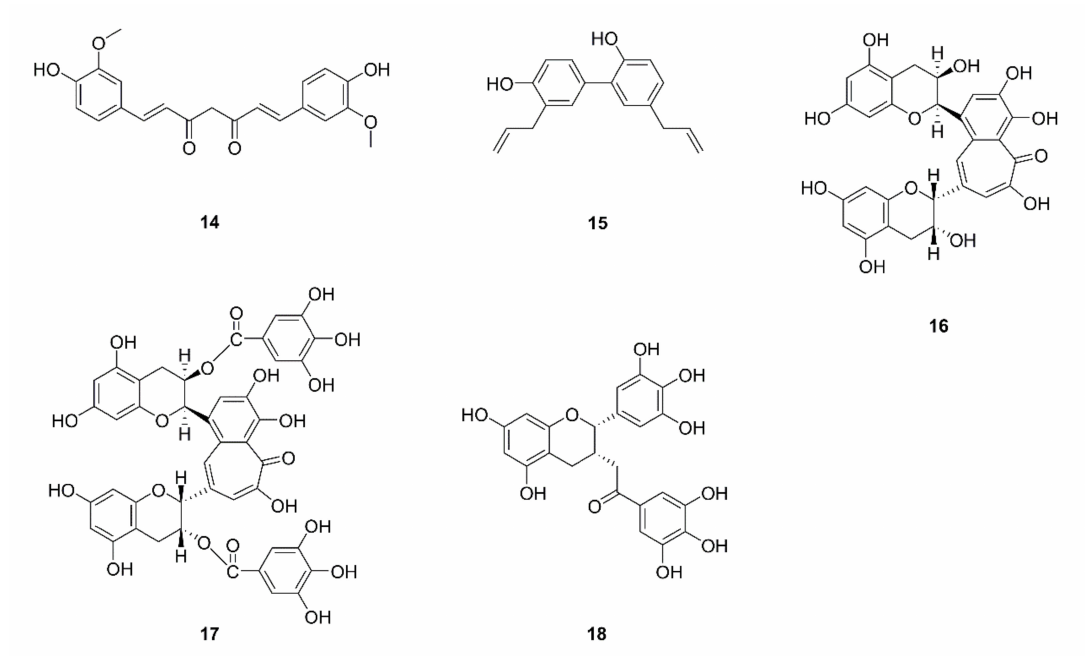
Figure 3. Chemical structures of natural compounds targeting the ECM ( 14 – 18 ). Steroidal saponins extracted from Paris polyphylla (PPSS) were shown to inhibit A549 cell growth, adhesion, migration and invasion in a concentration-dependent manner. The anti-invasive mechanism underlying these processes is that PPSS reduces the protein expression and activity of MMP-2 and MMP-9 [42]. Methanolic extract of Euchelus asper was also shown to exert anti-proliferative activities by decreasing the expression of MMP-2 and MMP-9 in vitro [43]. Another study reported that Phyllanthus urinaria extracts (PUE) suppress the migration and invasion of A549 and LLC cells through reduced expression of MMP-2, MMP-9, and u-PA [44]. Rose is one of the most important ornamental plants. A previous study reported that Rosa gallica petal extract (RPE) inhibits the proliferation, metastasis, and invasion of A375 cells by reducing the expression and activity of MMP-2 and -9. Different from the PUE, RPE was also shown to modulate the EGFR-MAPK and mTOR-Akt signaling pathways [45]. Viola Yedoensis extract (VYE) was not only found to inhibit the activity of MMP-2, -9, and u-PA, it was also shown to suppress the protein expression levels of TIMP-2, TIMP-1, and PAI-1 in A549 and LLC cells. Further research showed that VYE inhibits the binding of NF- κ B to DNA. Thus, the inhibition of NF- κ B suppresses MMP-2 and u-PA expression and lung cancer cell invasion [46]. Focal adhesion kinase (FAK) was found to be overexpressed and activated in some late-stage cancers. Activated p-FAK has been shown to promote migration and invasion and modulate u- PA and MMPs [93]. Active ERK1/2 was also shown to promote MMP production